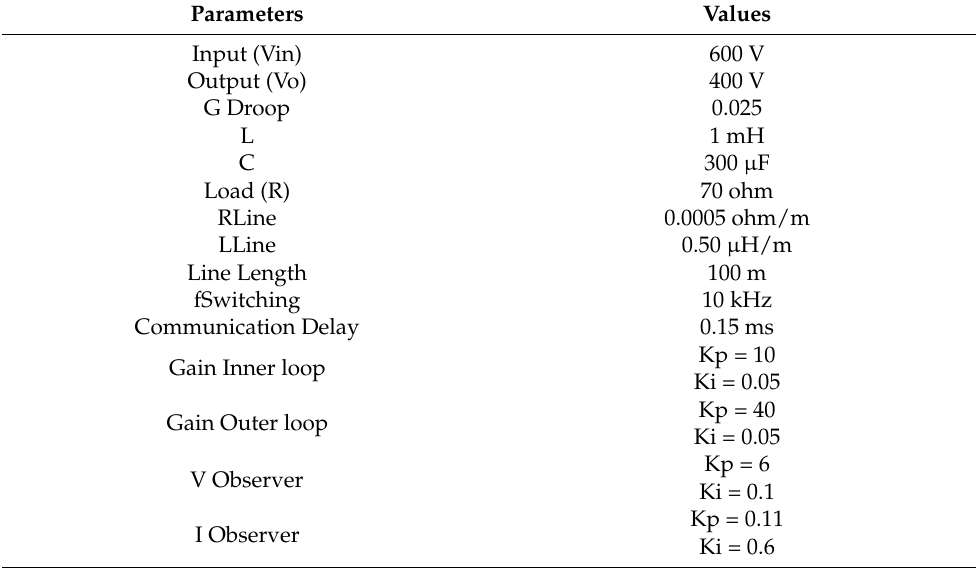
Figure 7. Physical Islanding Detection Scenario. ( a ) without fault; ( b ) with fault. Table 3. Parameters of each node.